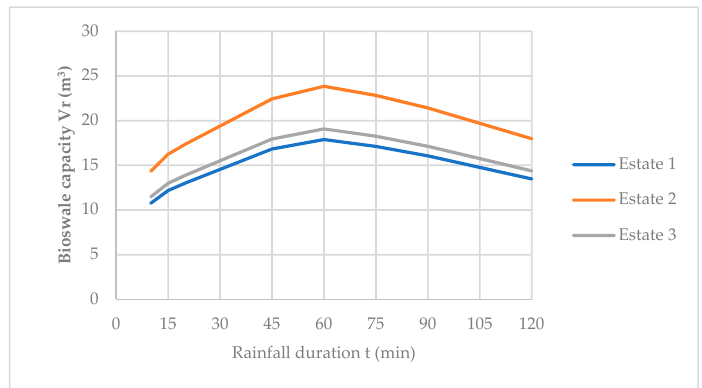
Figure 4. Results of calculations for determining the required volume of bioswale for estates 1, 2, and 3.